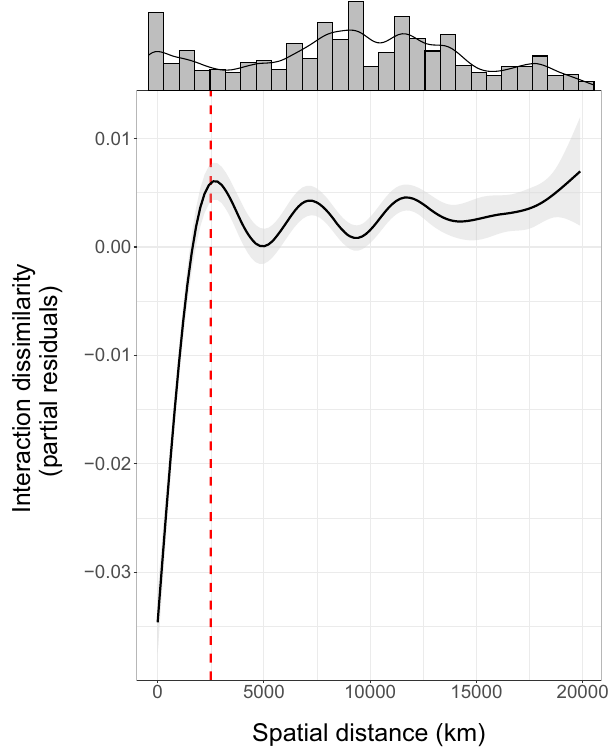
Fig. 6 | Partial effects plot of the relationship between spatial distance and interaction dissimilarity ( β WN ). Here, we show the fi t (solid line) of a Generalized AdditiveModel(GAM)withinteractiondissimilarityastheresponsevariableandall ourpredictorvariablesincluded.Thus,thisplotshowstheeffectofspatialdistance on interaction dissimilarity, while controlling for the effect of the other predictor variables in the model. Partial residuals remain on the same scale as the original data,butthe signofvaluesindicateshowtheydiffer from whatwould beexpected (i.e.,fromthe fi ttedvalues)basedontheotherpredictorvariablesinthemodel.The gray area represents two standard errors above and below the estimate of the smoothbeingplotted.Thehistogramabovetheplotshowsthedistributionofdata points across the spatial gradient. Note the sharp increase in interaction dissim- ilarityuntilathresholddistanceofaround2500km(dottedredline),beyondwhich few networks shared interactions (a similar pattern can be seen in Supplementary Fig. 14c). Source data are provided as a Source Data fi le.